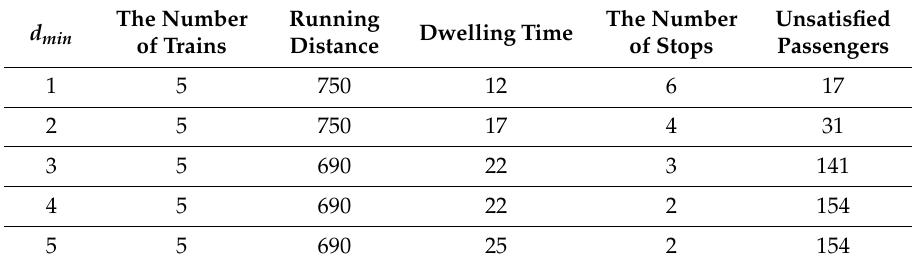
Table 8. Optimized solutions obtained under the minimum dwelling time d min